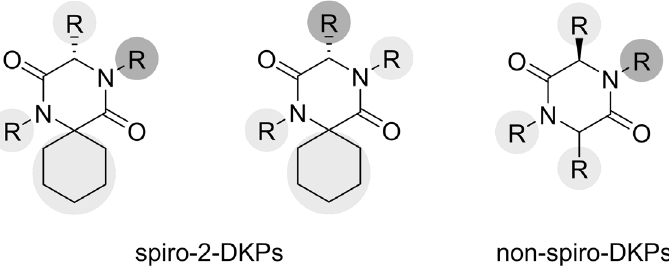
Fig 7. General structures of spiro-2-DKPs and non-spiro-DKPs. Hydrophobic substituents are indicated by light grey, while hydrophilic substituents are shown in dark grey.